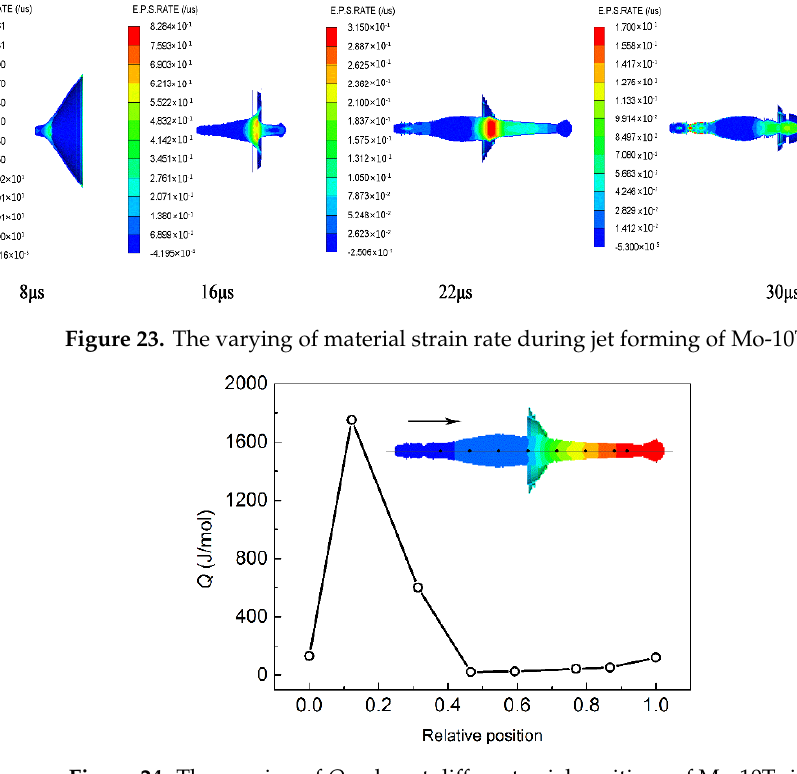
Figure 24. The varying of Q value at di ff erent axial positions of Mo-10Ta jet.